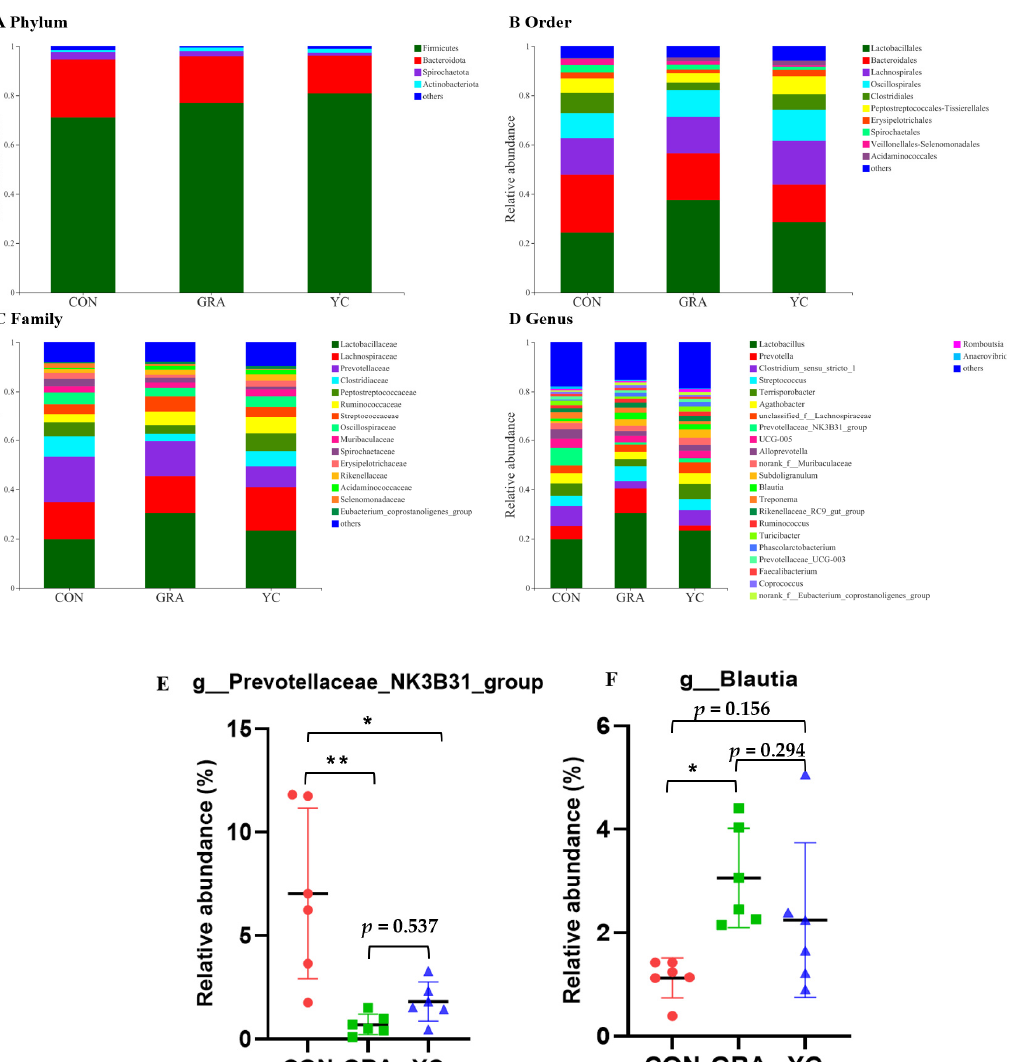
Figure 6. Effects of yeast culture on cecum chyme microbial composition. ( A ) The relative amounts of chyme microbiota at the phylum level. ( B ) The relative amounts of chyme microbiota at the order level. ( C ) The relative amounts of chyme microbiota at the family level. ( D – F ) The relative amounts of chyme microbiota at the genus level. Data are expressed as the mean ± SEM. * p < 0.05 and ** p < 0.01.